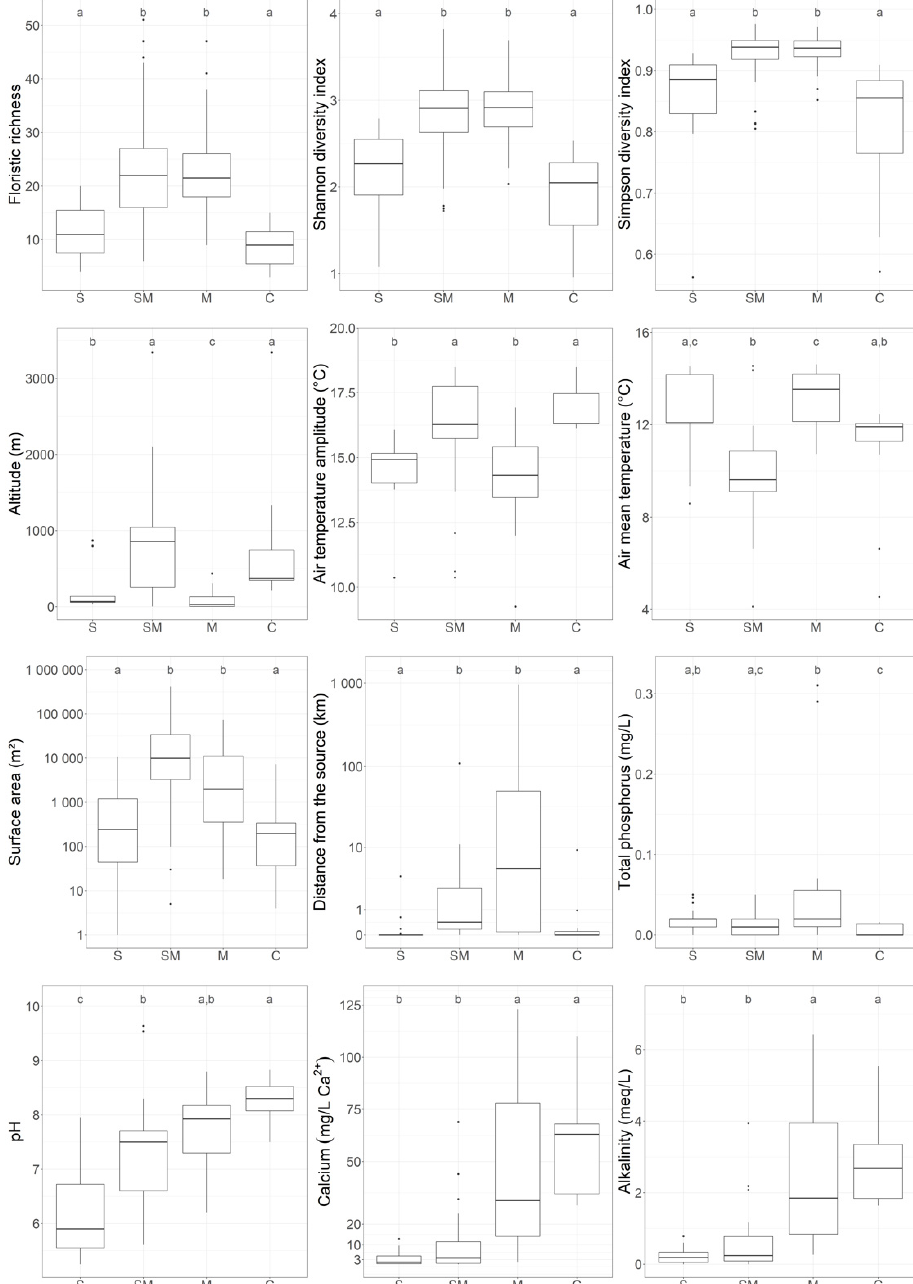
Figure 3. Box-plots of richness and diversity indices (Shannon’s index, Simpson’s index) and determinant environmental variables (pH, calcium concentration, alkalinity, surface area, distance from the source, total phosphorus). S = soft-water, SM = soft-water marginal, M = mixed, C = calcareous group. Small letters (a, b, c) indicated significant differences between the groups (Dunn’s test).